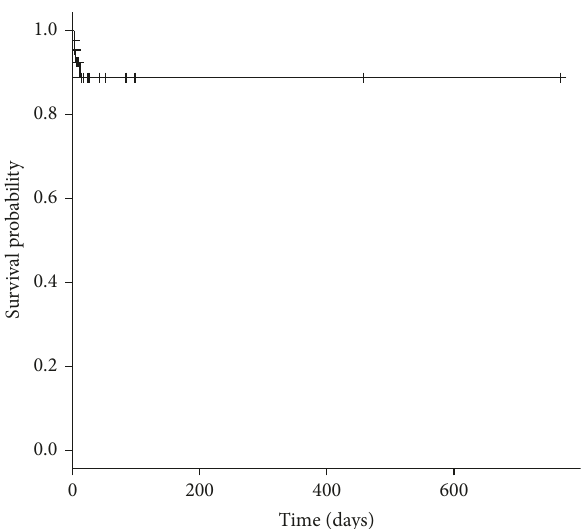
Figure 4: Control of pulmonary nodule growth after stereotactic body radiotherapy (SBRT) treatment.